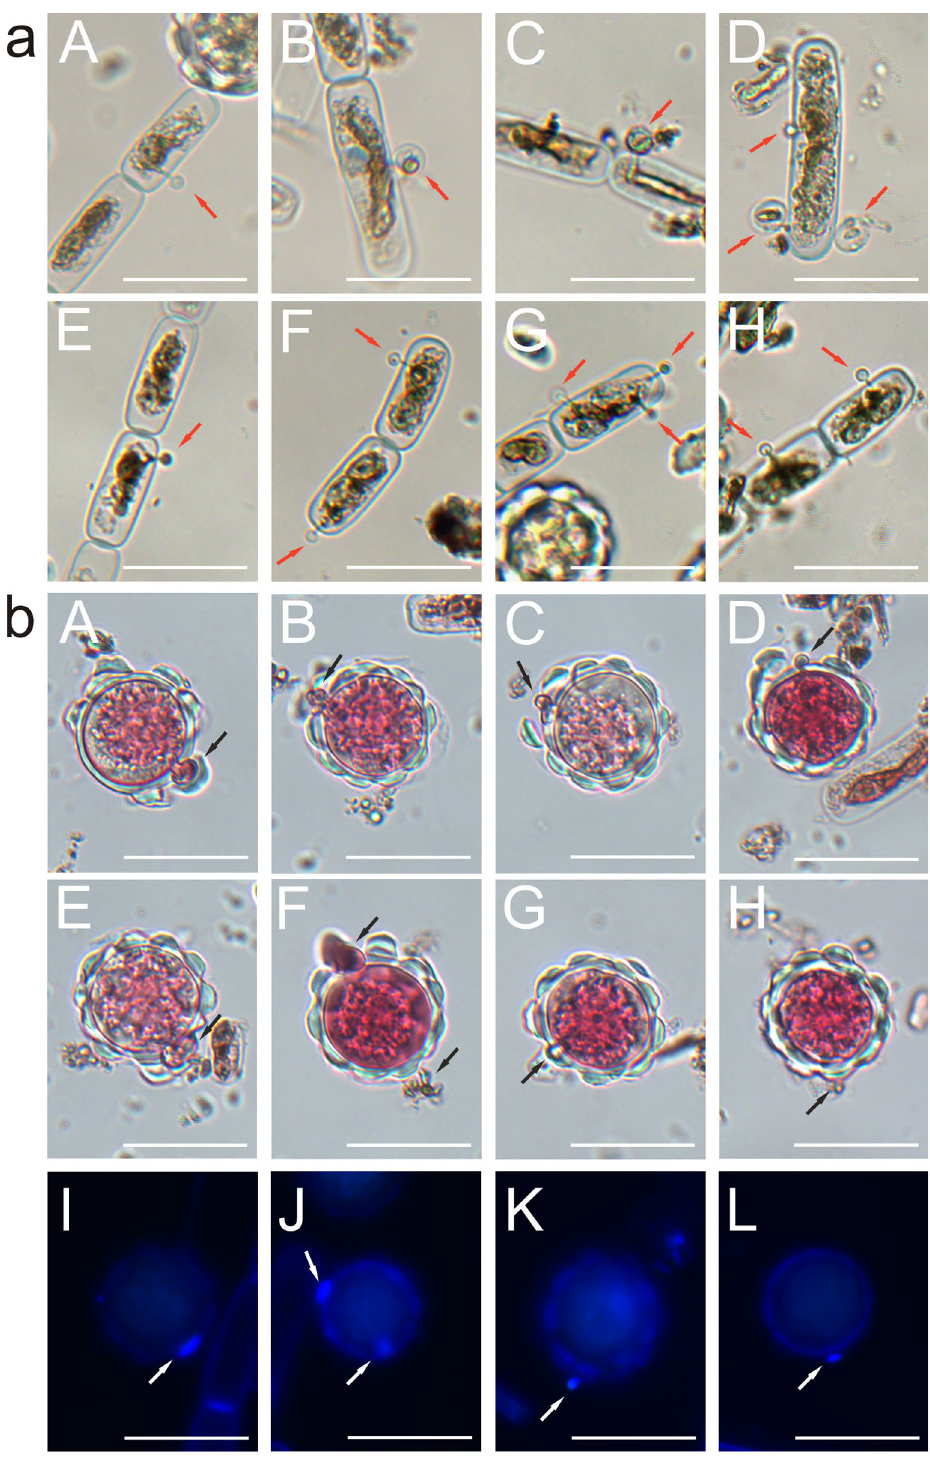
Figure 8. A. nordenskioeldii algae infected by fungi. (a) —the pictures were taken in brightfield microscopy; chytrids are visible as small circular structures attached to the algal cell walls (marked by red arrows) (b) hypnozygotes of S. nivaloides algae infected by the fungus after staining with propidium iodide observed in brightfield microscopy; the dye penetrated cells with a damaged wall and by binding with the genetic material. A–H-fungal cells growing in hypnozygotes; I–L hypnozygotes infected by fungi after staining with Calcofluor white; the chitin in the fungal cell wall fluoresces much more intensely than in the algal